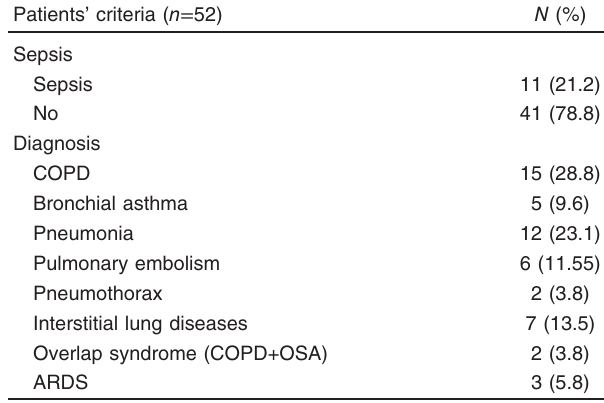
Table 2 Characteristics of the studied patients with regard to critical illness, presence of sepsis, and